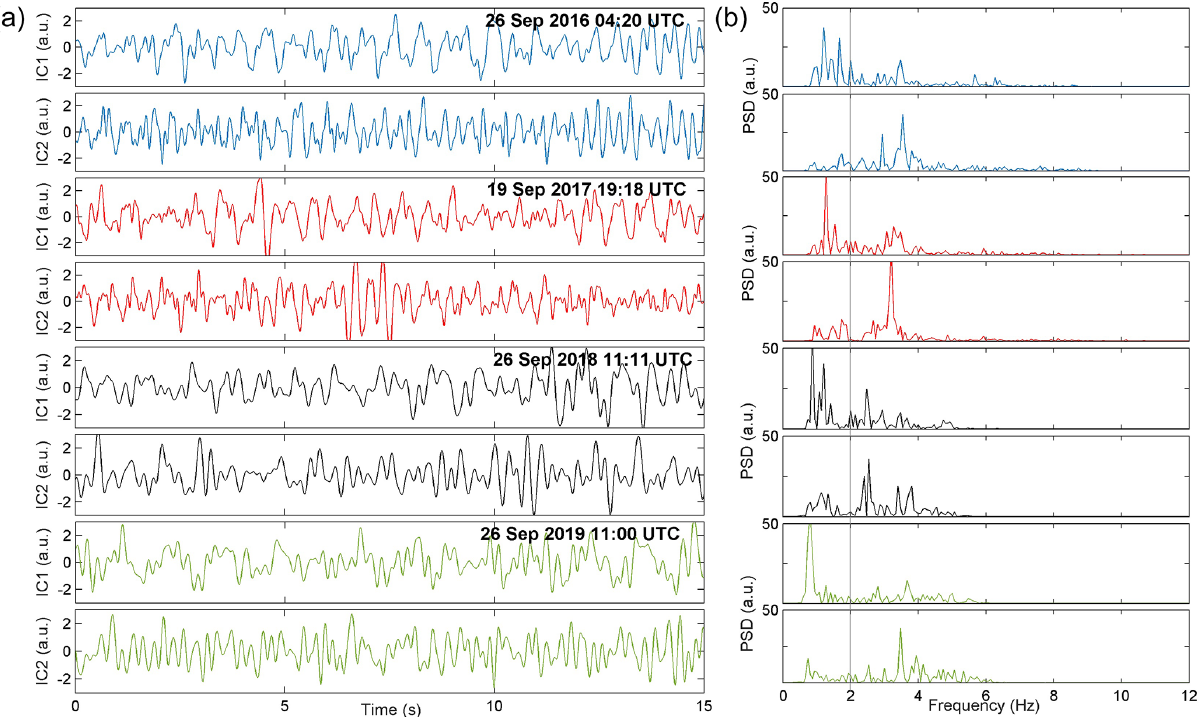
Figure 4. Examples of the ICA results relative to the seismic noise for IOCA station. The plots for the year 2016 are represented in blue, 2017 in red, 2018 in black and 2019 in green. In panel (a) , we report the ICs’ signals (IC1 and IC2); in panel (b) , the corresponding estimated PSDs. The starting time of the used time-windows are indicated. The grey vertical line on the PSD plots evidences that the two ICs are well separated in the frequency